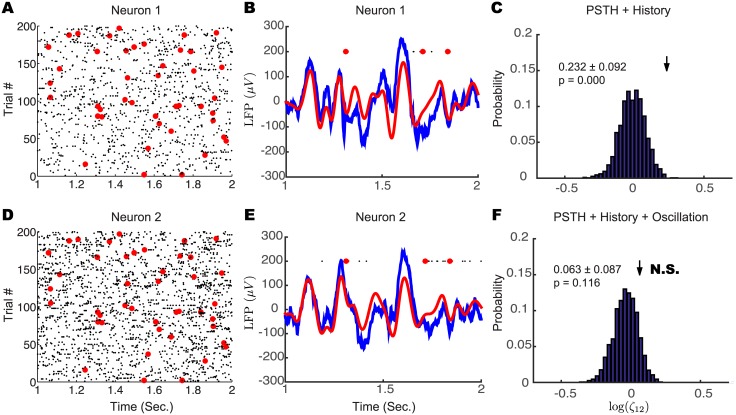
Shared oscillations contribute to spike synchrony between V4 neurons in vivo.(A,D) Raster plot of spike trains from two neurons recorded simultaneously. Red circles show synchronized spikes between the two neurons. (B,E) Raw (blue) and 4–25 Hz filtered (red) surrounding LFP related with each neuron for a single trial. (C,F) The simplified model failed to explain the observed number of synchronous spikes (C), while the full model containing an oscillatory factor fully accounts for the observed number of synchronous spikes.